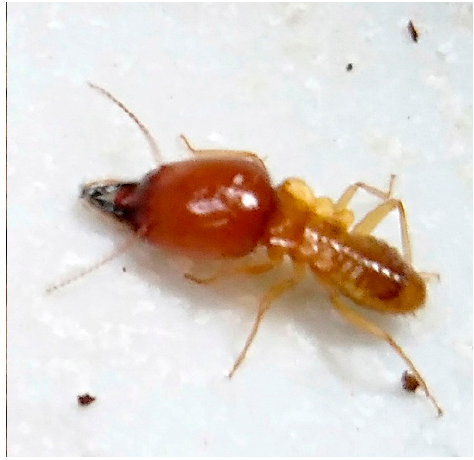
Figure 2. Subterranean soldier termite that found on the specimens.